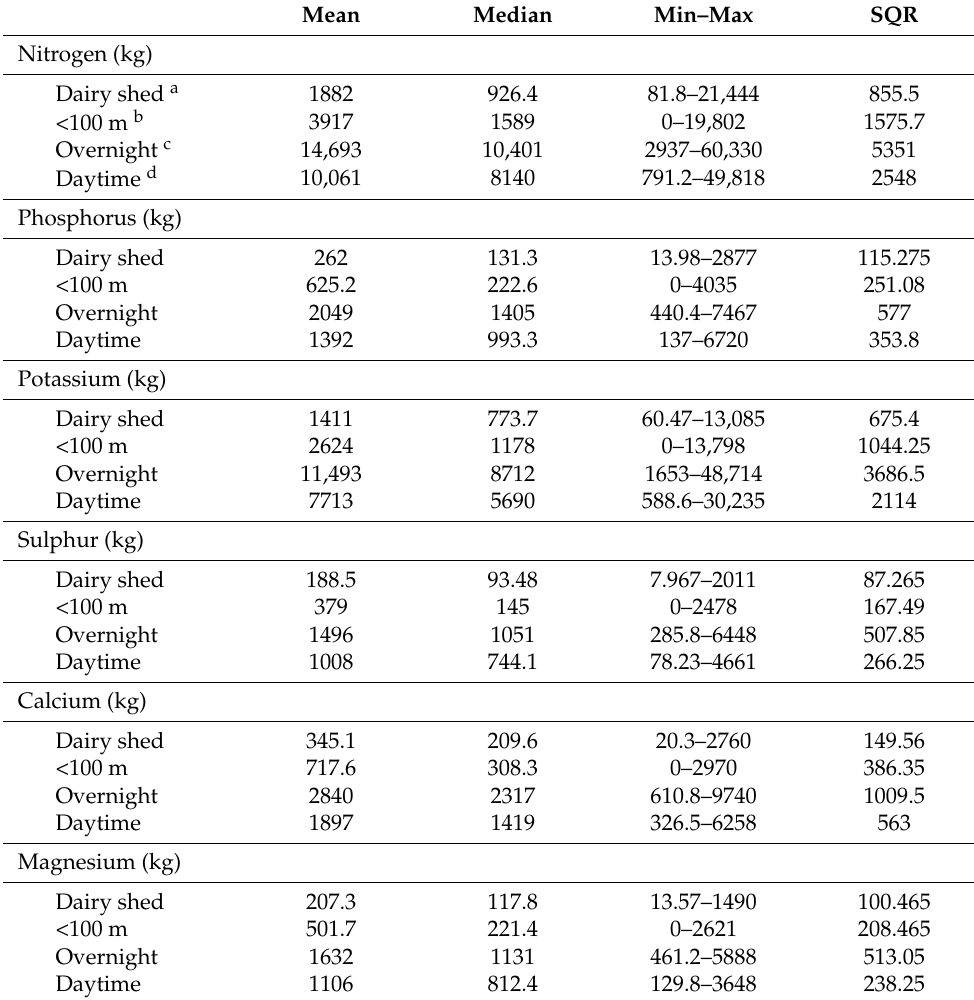
Table 8. Summary statistics (mean, median, range and semi–quartile range) for nutrient loads (kg) excreted over a lactation (305 days) by the lactating herds at the dairy shed and yards, within 100 m of the dairy shed, and in paddocks grazed overnight or in the daytime, on 42 dairy